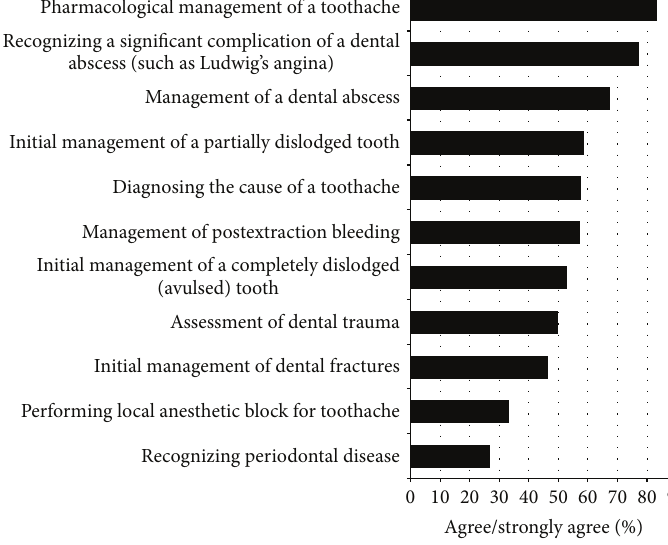
Figure 2: Practitioner confidence in specific topics of dental emergencies.